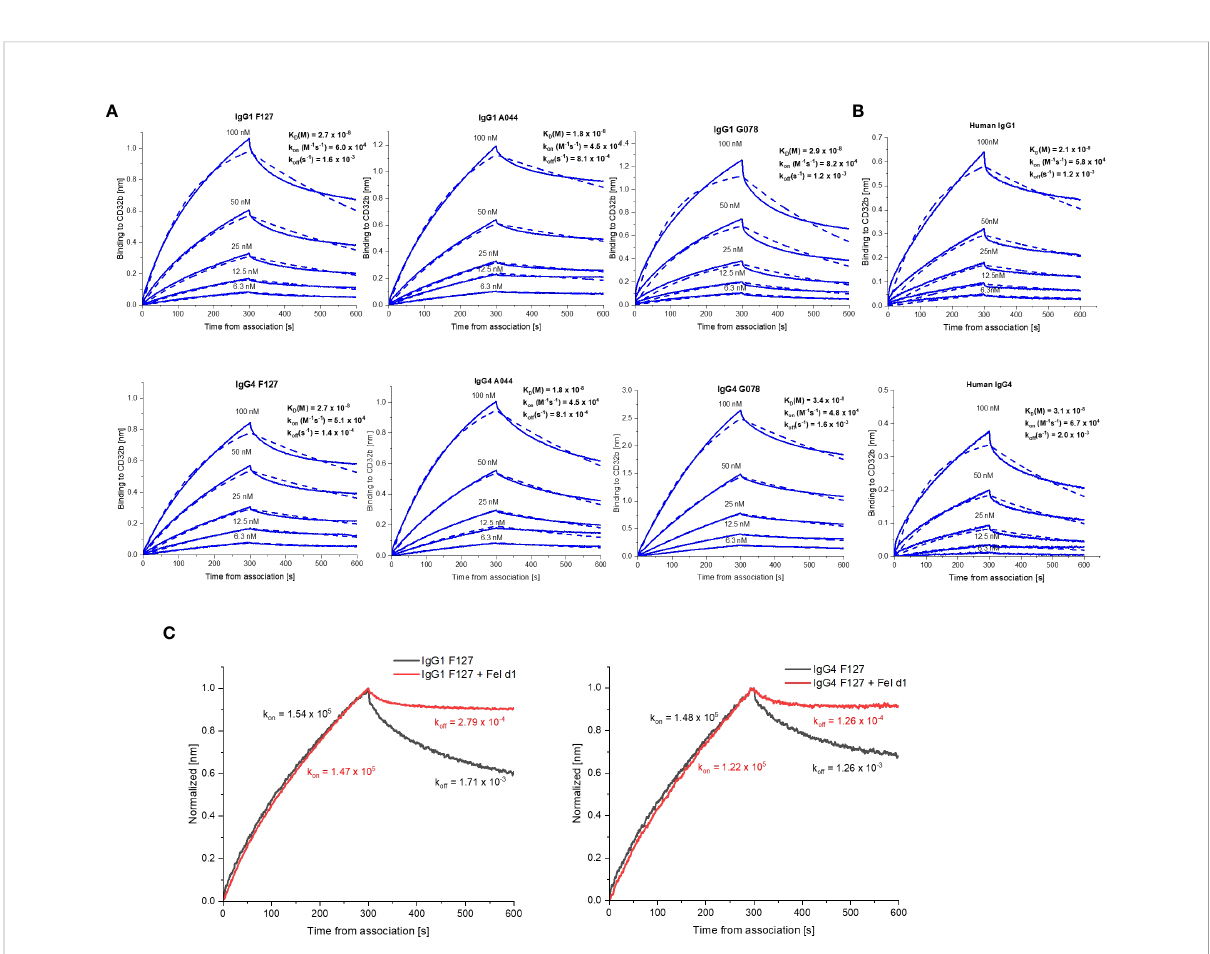
FIGURE 5 BLI sensorgrams illustrating the interaction IgG1 and IgG4 antibodies to Fc g RIIb. (A) Binding of monomeric F127, G078 and A044 in either IgG1 or IgG4 format. (B) Binding of human native IgG1 or IgG4. (C) Binding of IgG1 and IgG4 F127 either as monomer or in pre-complexed form with Fel d 1. The on-rate (k on ) and off-rate (k off ) constants were compared. In both assays association and dissociation were performed 300s.